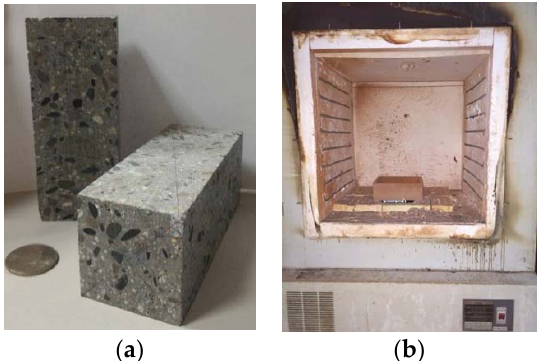
Figure 1. Thermo ‐ induced ‐ damage concrete specimen preparation: ( a ) concrete specimen; ( b ) high Figure 1. Thermo-induced-damage concrete specimen preparation: ( a ) concrete specimen; ( b ) high temperature oven. temperature